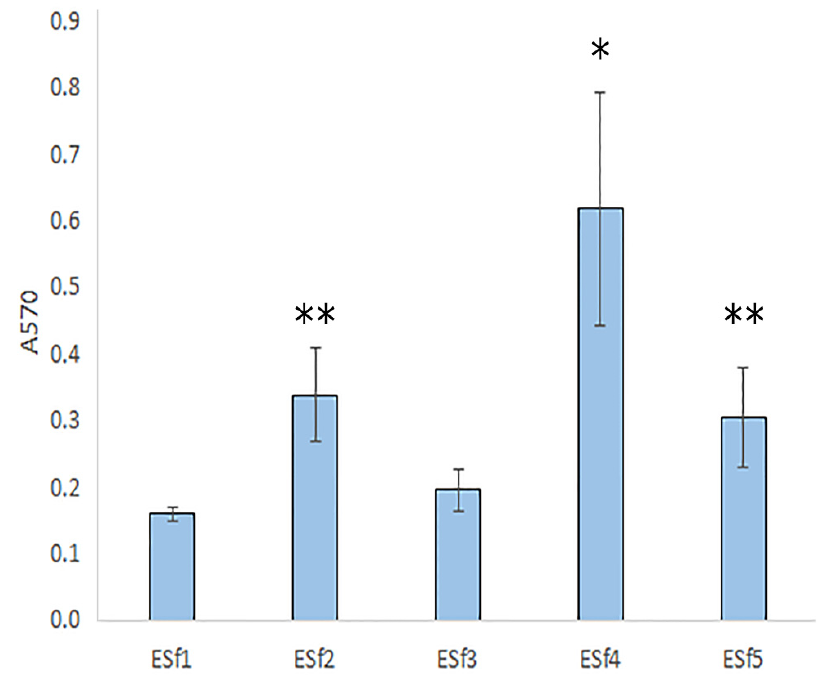
Figure 4. MTT assay results of UC-MSC adhesion on different scaffolds at 48 h after cell seeding. *—significant difference in cell adhesion between the ESf4 scaffold and all other scaffolds ( p < 0.05). **—significant differences in cell adhesion between the ESf2 or ESf5 scaffold and ESf1 scaffold ( p < 0.05).